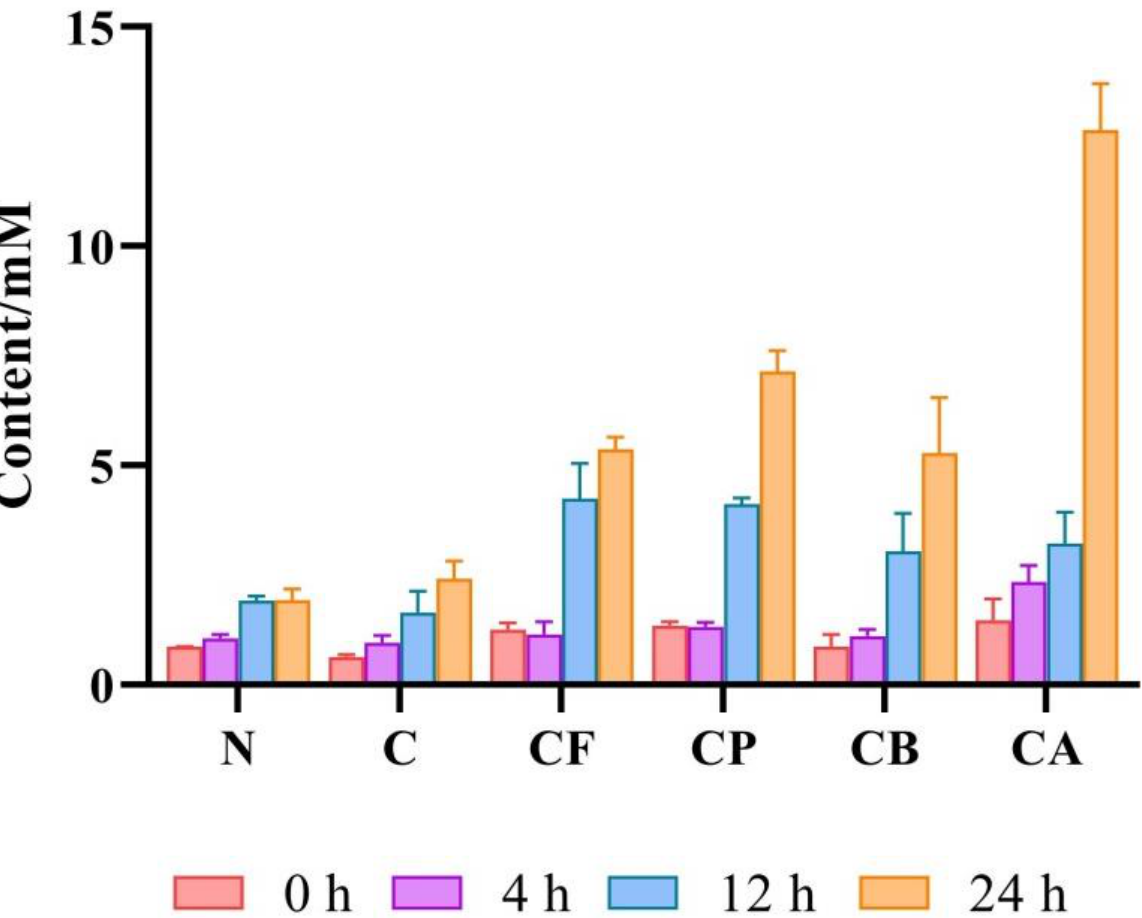
Figure 7. Total C3G SCFAs mixed with different polysaccharides during in vitro fermentation.